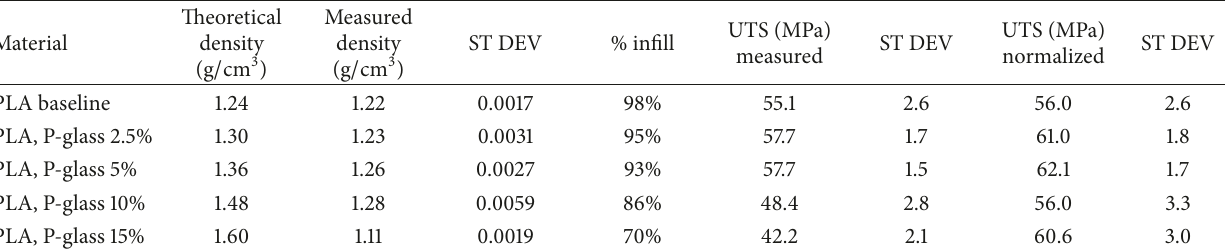
Table 7: Normalized UTS data for the PLA